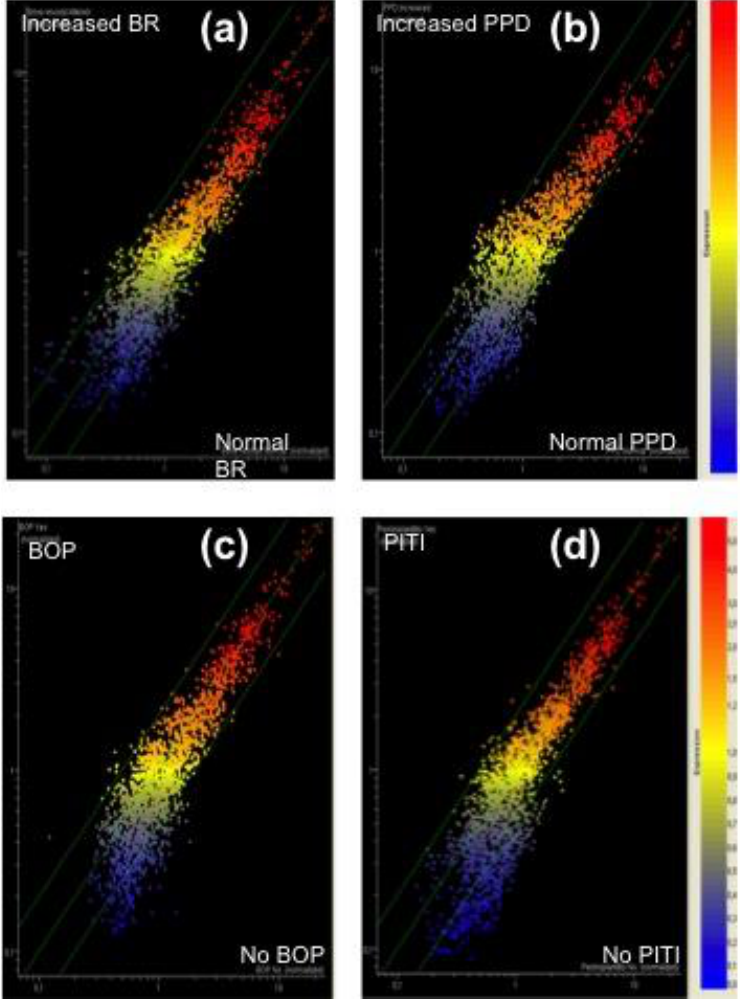
Figure 2. Scatter plot analyses reporting the alteration of microRNA (miRNA) profile as related to the outcome of the following clinical variables recorded at the five-year follow-up appointment: ( a ) bone